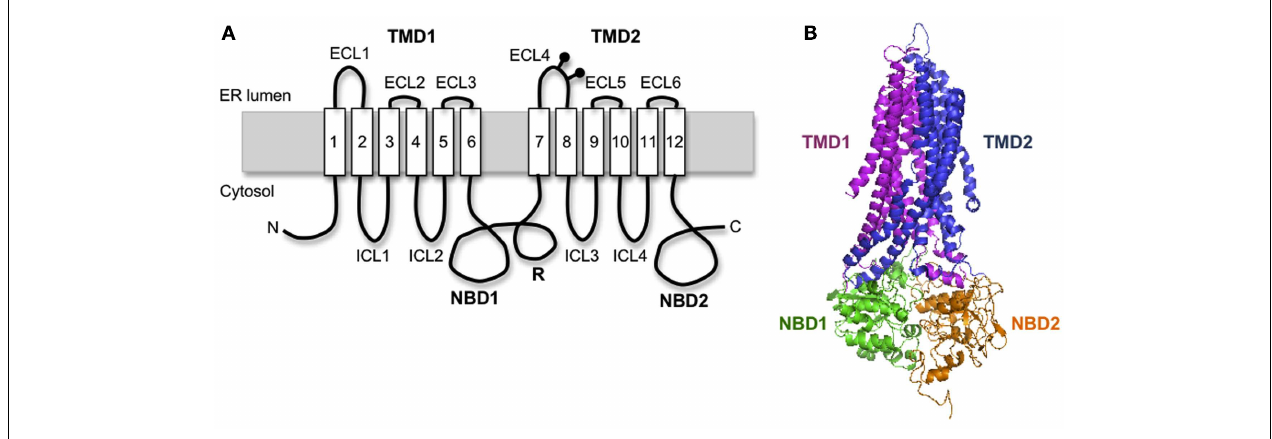
FIGURE 1 | Cystic fibrosis transmembrane conductance regulator structural organization. (A) Schematic diagram of CFTR showing transmembrane topology and domain organization. (B) A predicted human CFTR structure based on homology model from